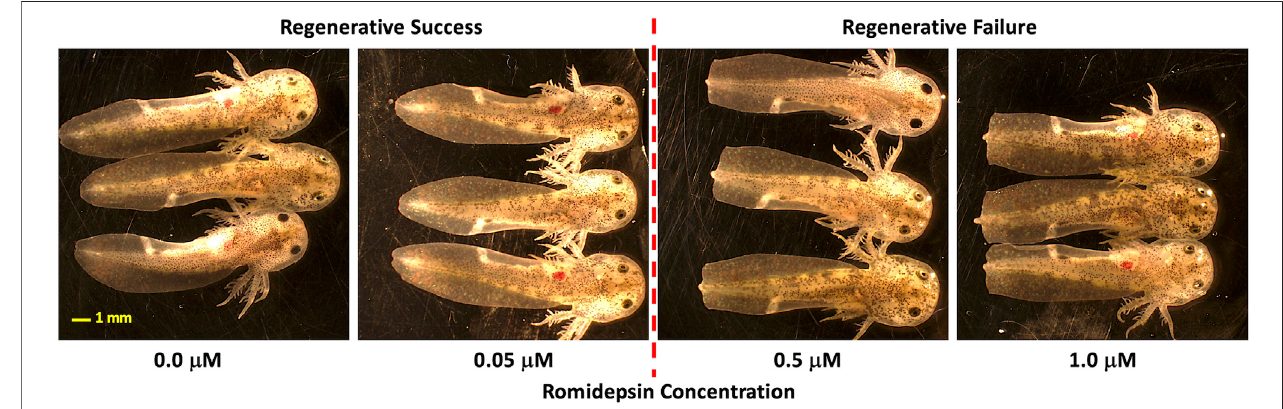
FIGURE 1 | Concentration dependent effect of romidepsin on tail regeneration. Embryos that were treated continuously for 6 and 12 HPA with ≤ 0.05 μ m romidepsin fully regenerated their tails while embryos treated with ≥ 0.5 μ m romidepsin presented blunt-shaped tails (a non-regenerative outcome).